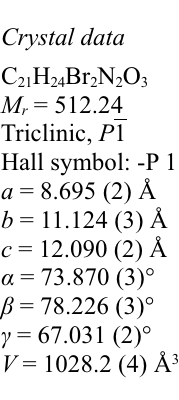
Molecular packing of (I), viewed along the a axis. Intermolecular hydrogen bonds are shown as dashed lines.